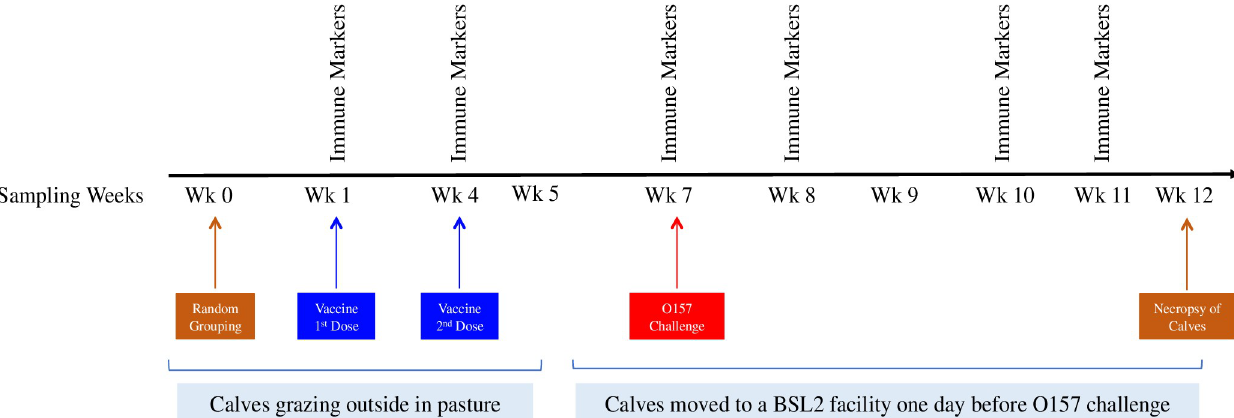
Fig 1. Experimental outline for animal vaccination and collection of fecal and blood samples. Calves (n = 16) were randomly assigned to one of four groups on week 0 (4 animals/group). Two groups of calves were vaccinated intramuscularly on week 1 followed by a booster dose on week 4. Vaccinated and challenged (Vx E -Ch and Vx C -Ch) and non-vaccinated but challenged (NonVx-Ch) calves were orally inoculated with E . coli O157:H7 on week 7 while the non-vaccinated and non-challenged (NonVx-NonCh) calves received sterile PBS. Fecal samples for culture and microbiota analysis were collected at weeks 0, 1, 4, 5, 7, 8, 9, 10 and 11. An additional fecal sample for culture was collected at necropsy. Blood samples for immune markers were collected at weeks 1, 4, 7, 8, 10 and 11.